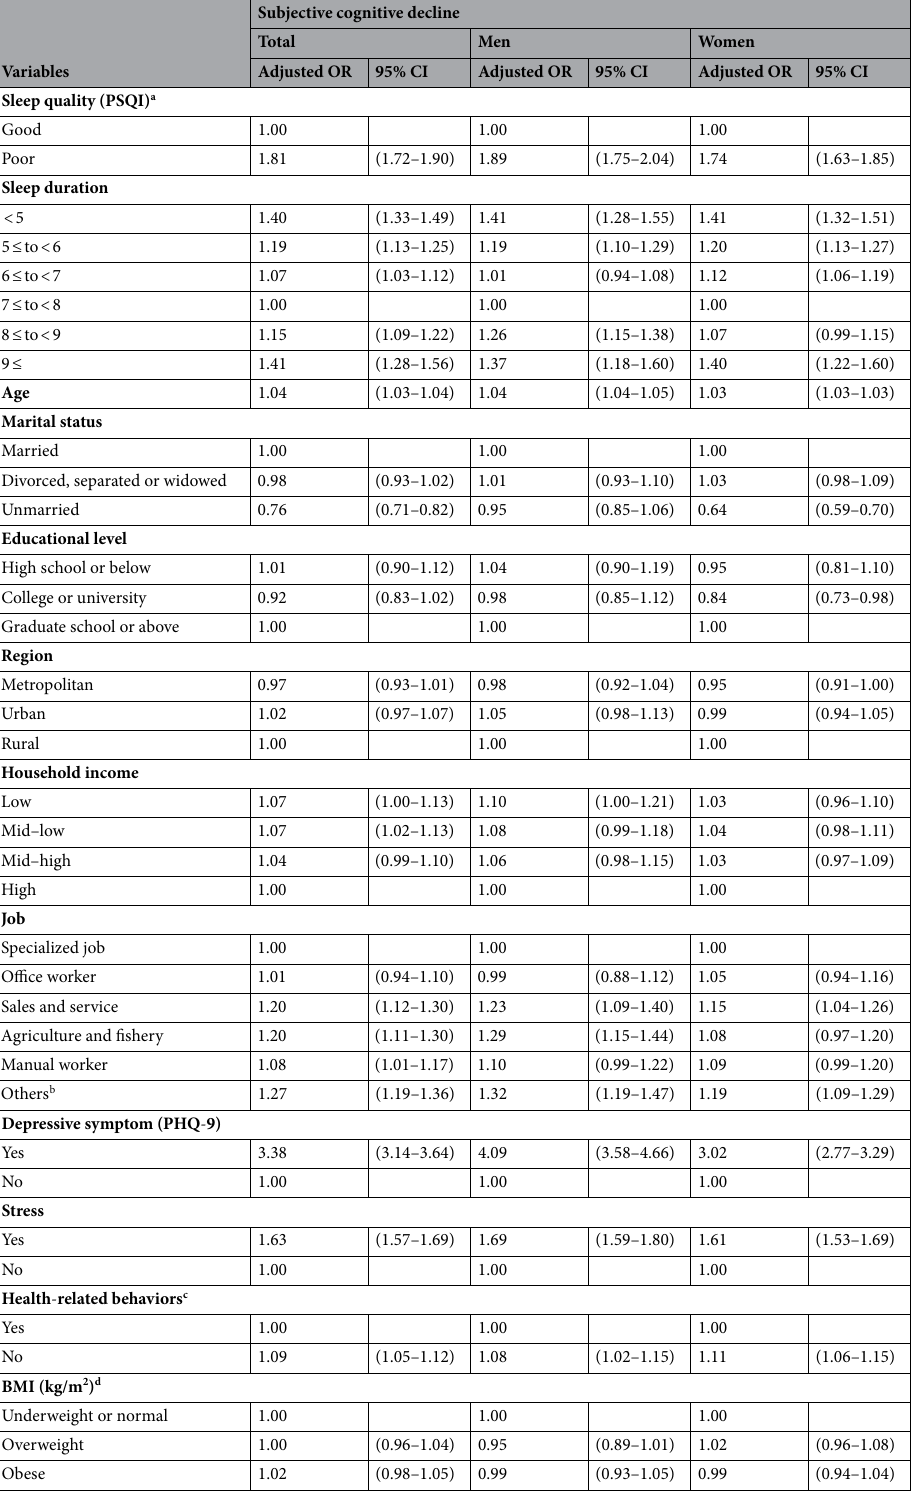
Table 2. Odds ratio for subjective cognitive decline. PSQI Pittsburgh Sleep Quality Index, CI confidence interval, OR odds ratio, PHQ-9 Patient Health Questionnaire-9. a Sleep quality: Sleep quality was measured using the Korean version of Pittsburgh Sleep Quality Index (PSQI - K). Good sleep quality ≤ 5, poor sleep quality > 5. b Others: Others include students, housewives, the unemployed and exclude occupational